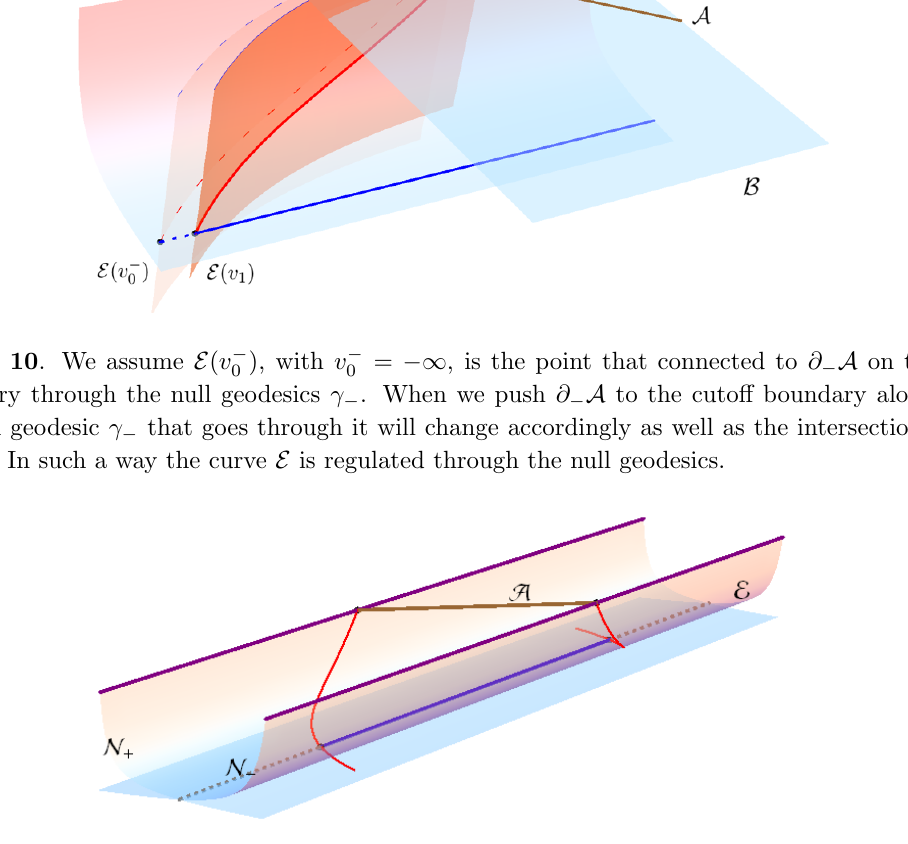
Figure 11 . In this (cid:12)gure the interval A is on the cuto(cid:11) boundary r = r I and its endpoints @ (cid:6) A are on N (cid:6) . The two red lines are the two null geodesics (5.25) which intersect with E at the endpoints of E reg (the solid blue